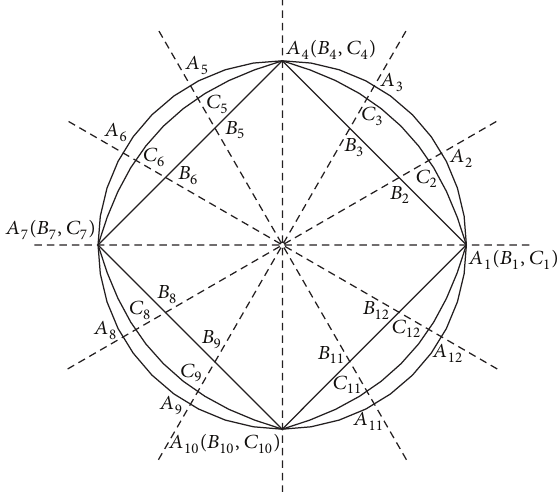
Figure 2: Ray firing method to find the vertex correspondence between a pie and a